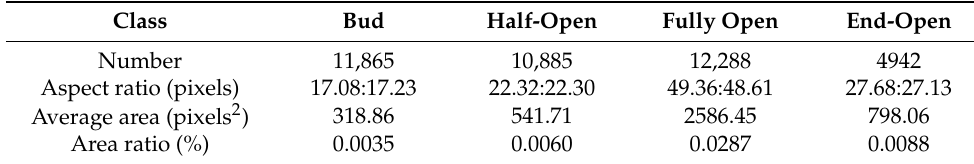
Figure 2. Flower images of apple tree at four flowering stages (300 × 300 pixels). ( a ) First flowering stage; ( b ) middle flowering stage; ( c ) full flowering stage; ( d ) last flowering stage. Table 2. Unprocessed annotation data information.